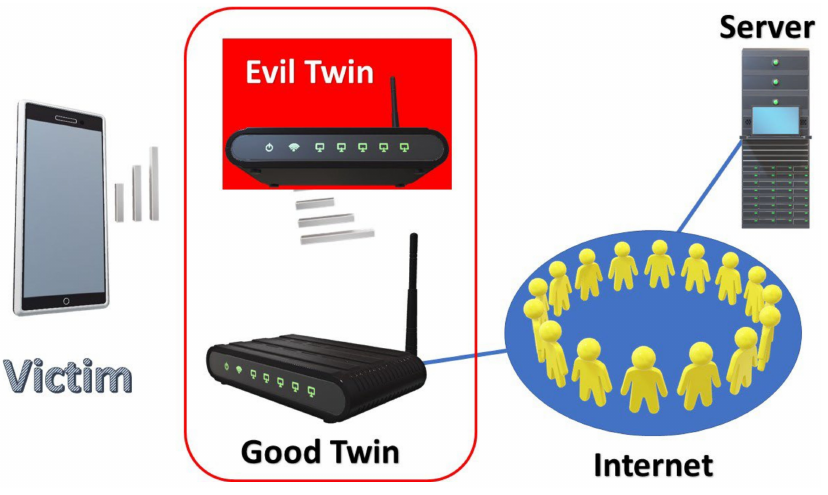
Figure 1. A scenario of an evil twin